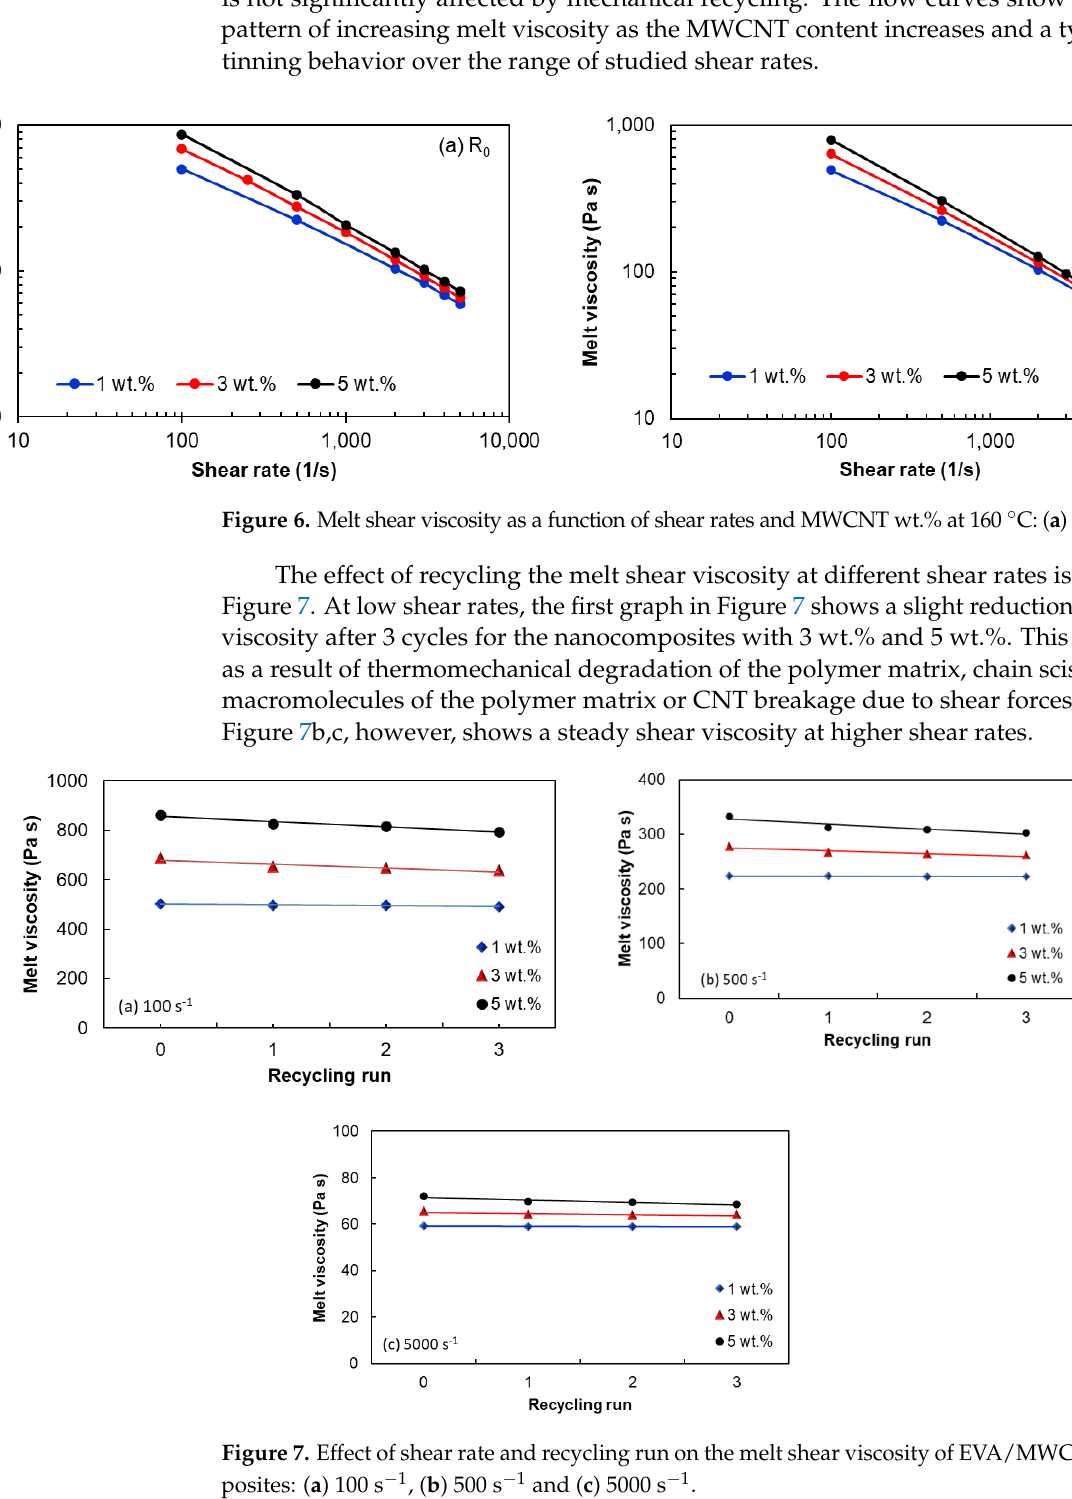
Figure 7. Effect of shear rate and recycling run on the melt shear viscosity of EVA/MWCNT nano- posites: ( a ) 100 s − 1 , ( b ) 500 s − 1 and ( c ) 5000 s − 1 composites: ( a ) 100 s − 1 , ( b ) 500 s − 1 and ( c ) 5000 s − 1 .